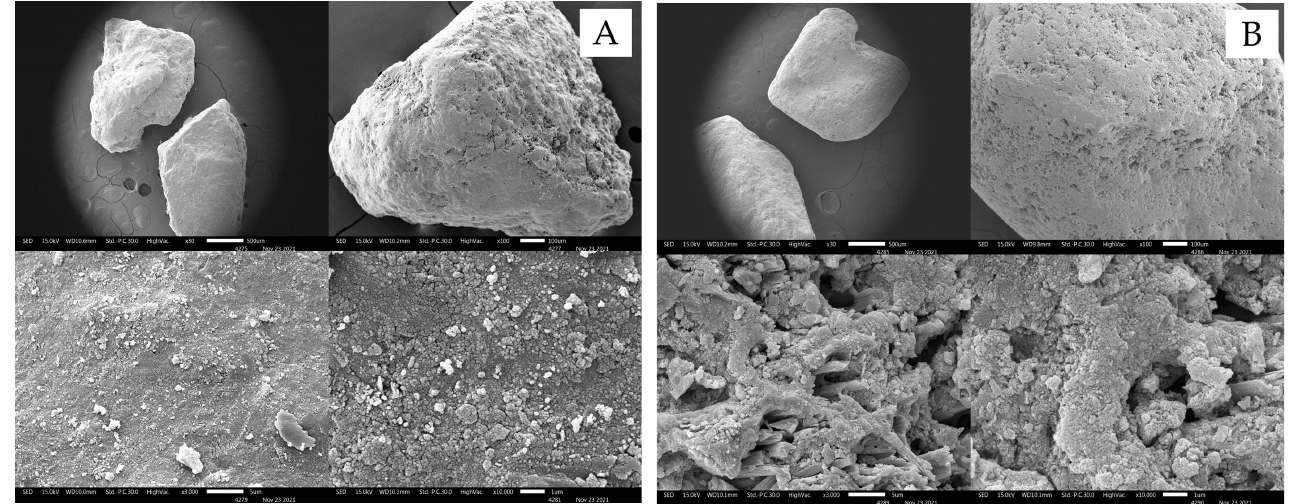
Figure 1. SEM analysis of ( A ) pyrolusite (washed by DI; PA-1) and ( B ) acid-modified pyrolusite (soaked with HCl; PA-2).